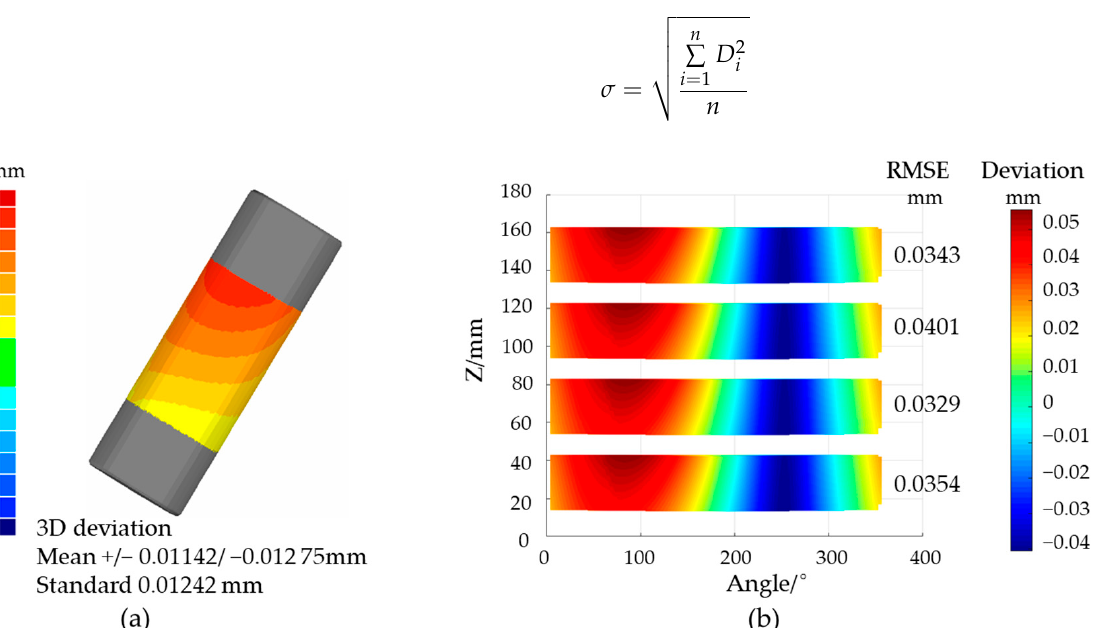
Figure 11. Measurement results: ( a ) the standard cylinder; ( b ) the repeatability verification.